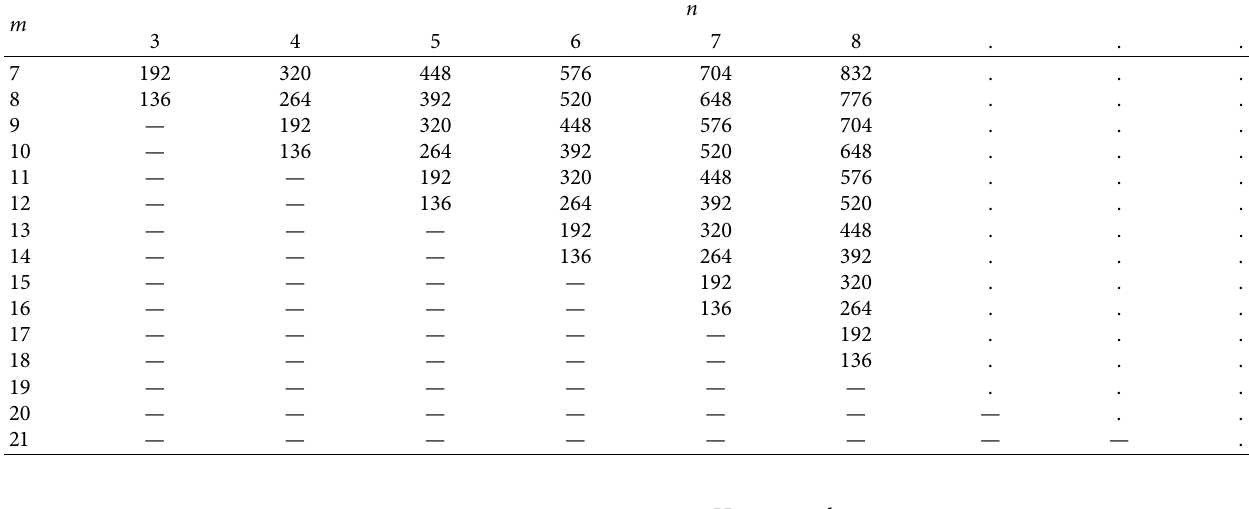
Table 4: Number of pair of vertices of HHC-2 at different